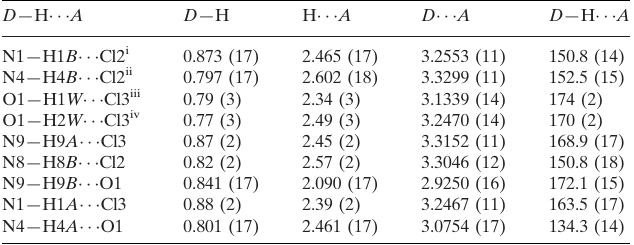
Hydrogen-bond geometry (A˚ , (cid:3)